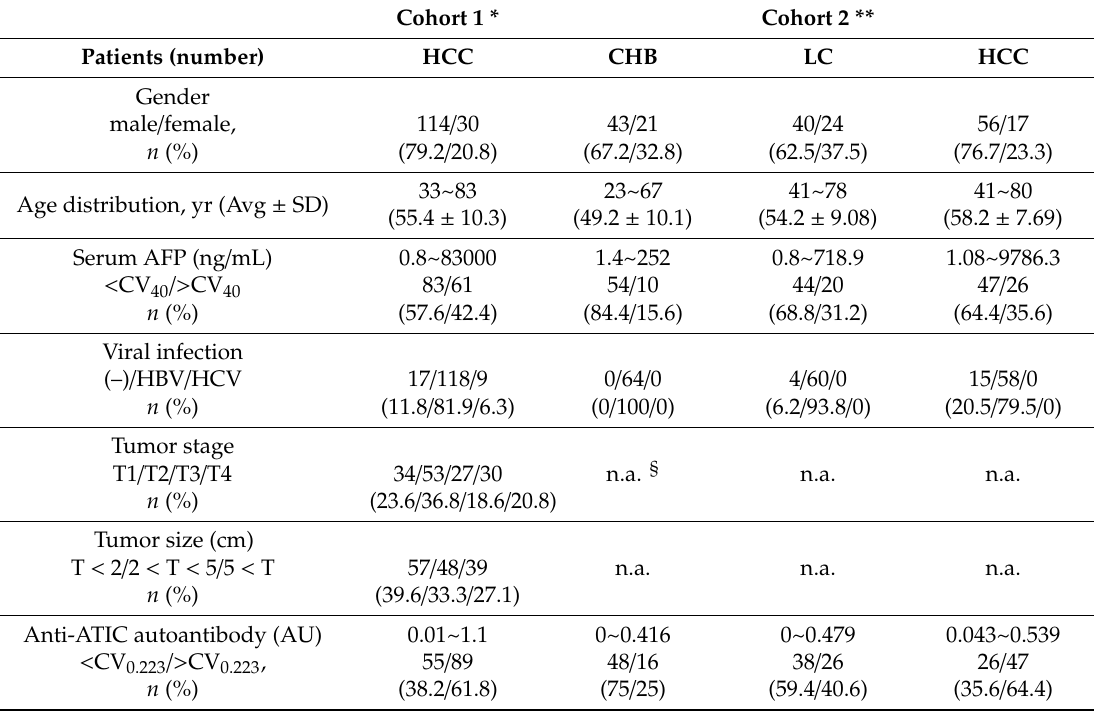
Table 3. Patient details in validation cohorts